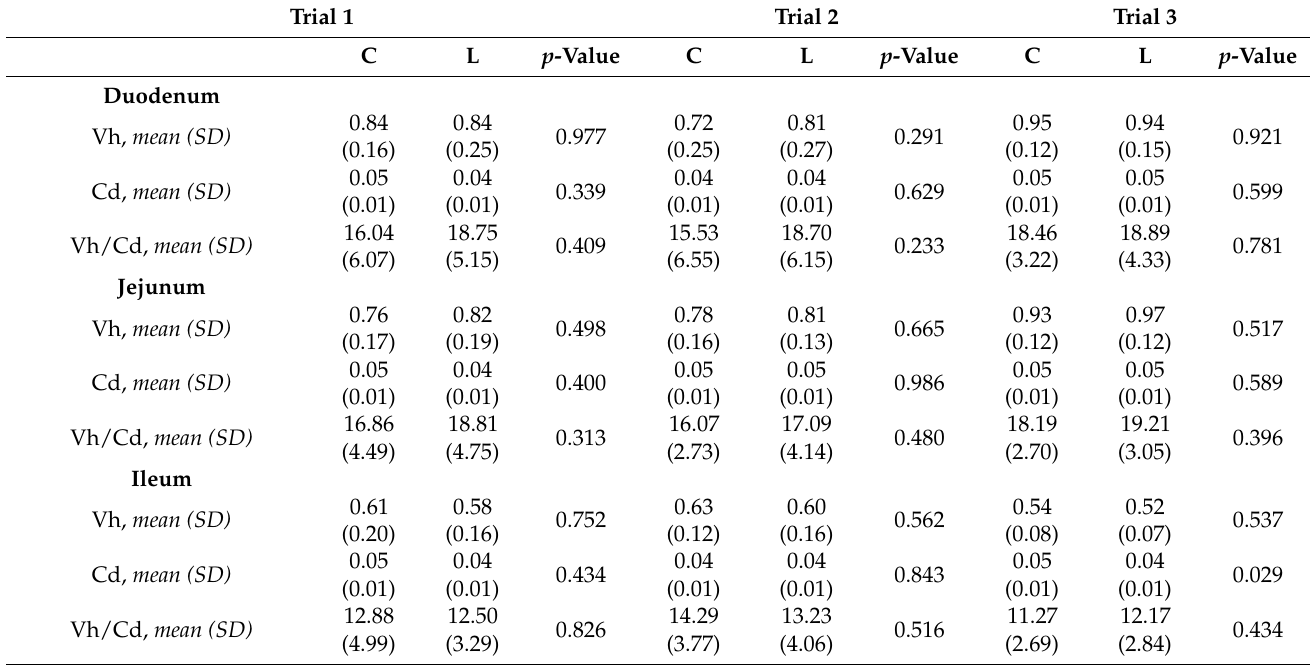
Table 5. Morphometric evaluation of the small intestine between control and probiotic group of trial 1, 2 and 3.